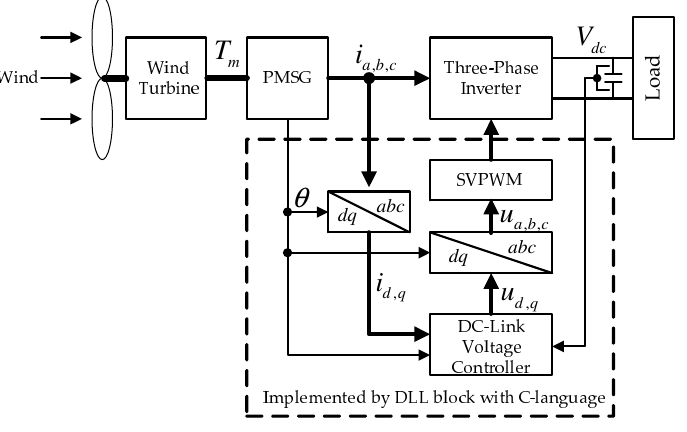
Figure 2. The implementation of the closed-loop